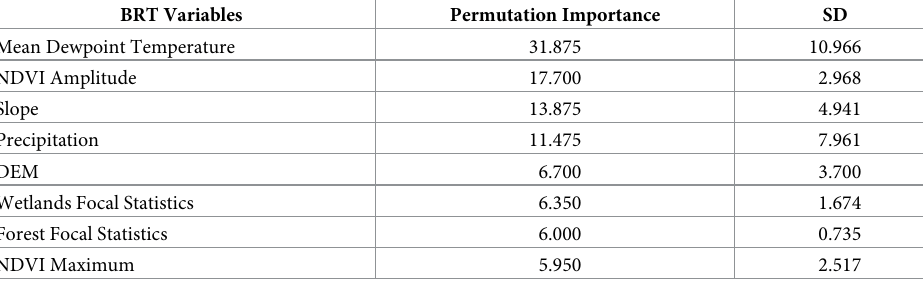
Table 1. Boosted regression tree variable permutation